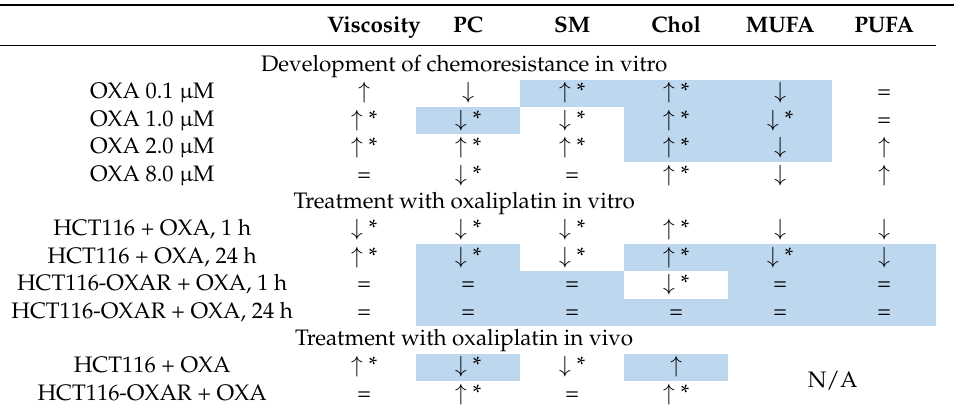
Table 1. Summary of the changes in membrane viscosity and the lipid profile of HCT116 cells upon treatment with oxaliplatin and the development of